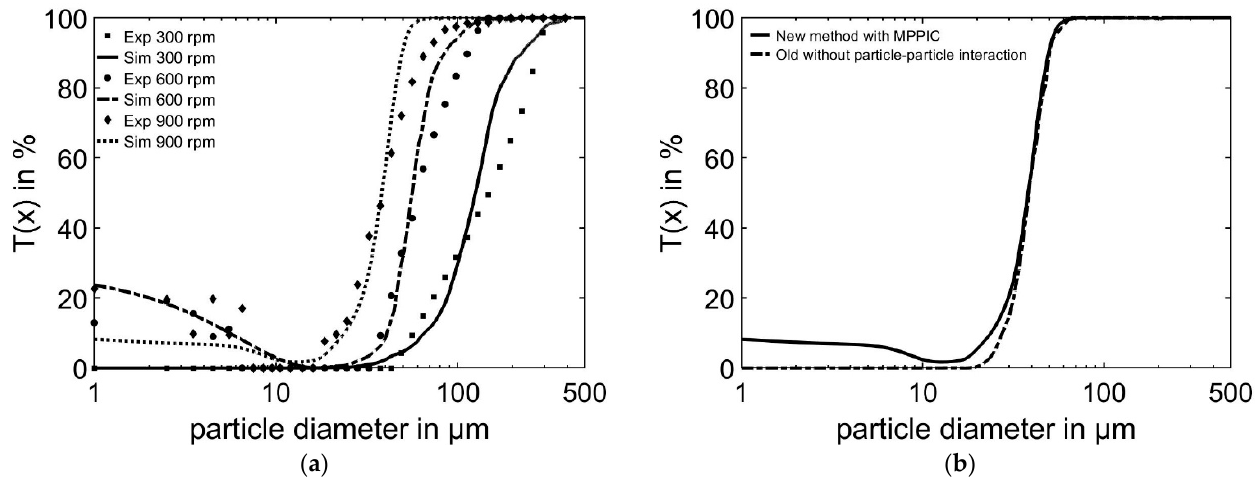
Figure 9. Unsteady particle movement in the apparatus at two different times at 900 rpm; ( a ) after 15 s; ( b ) after 20 s.